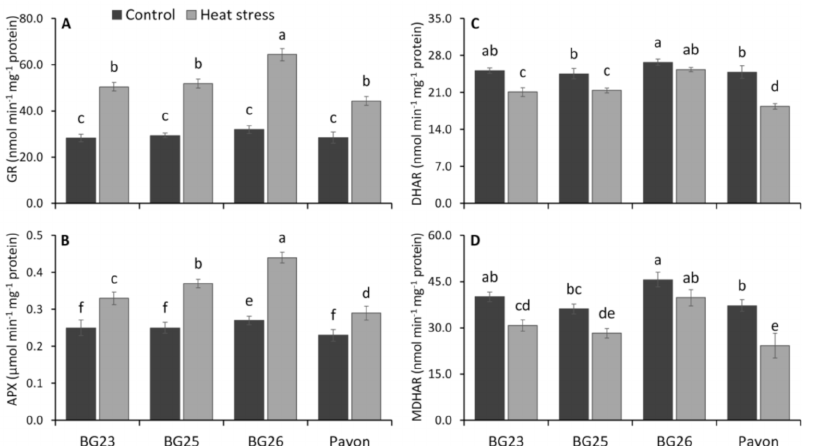
Figure 7. The specific activity of ( A ) glutathione reductase (GR), ( B ) ascorbate peroxidase (APX), ( C ) dehydroascorbate reductase (DHAR) and ( D ) monodehydroascorbate reductase (MDHAR) of wheat varieties under control and heat-stressed conditions. Vertical bars represent +/ − SE values. Different letter(s) indicate significant difference at p <